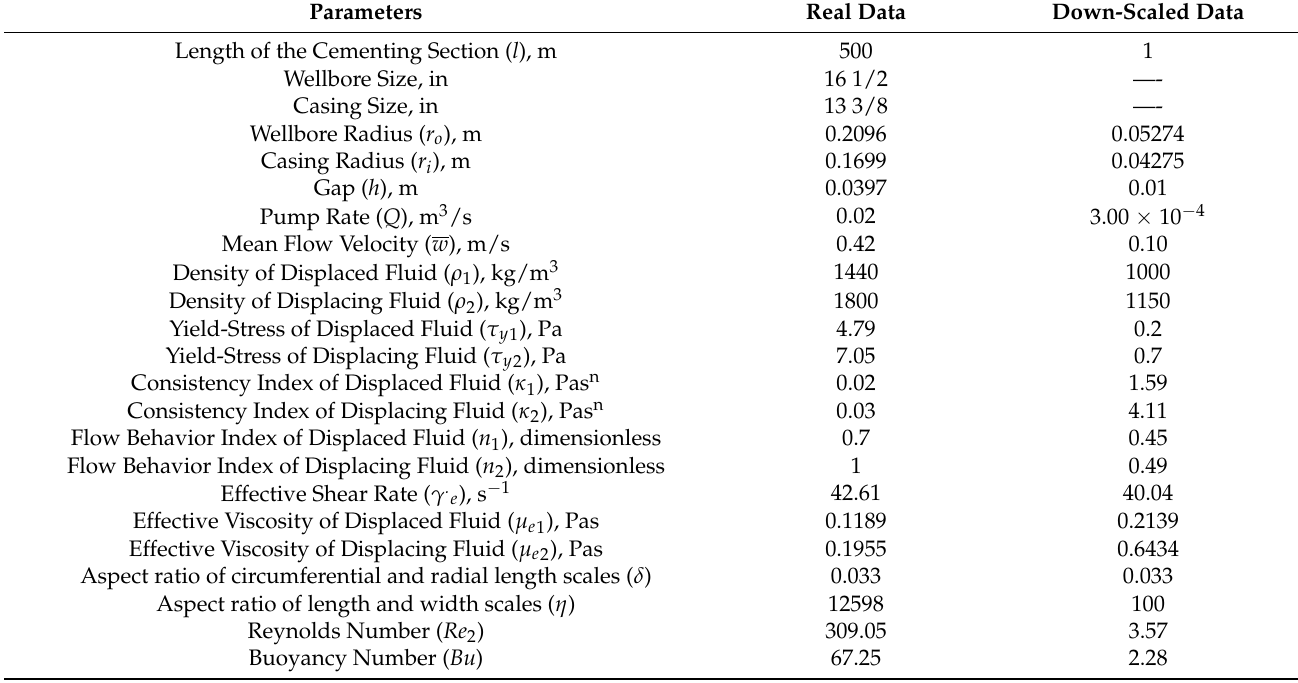
Table 1. Real and down-scaled concentric wellbore annulus data [5,8,9,12,25]. Parameters Real Data Down-Scaled